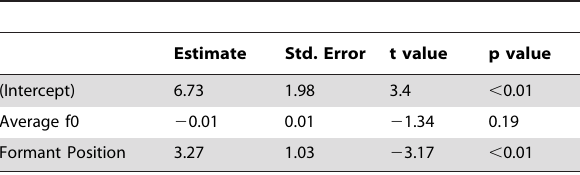
Table 9. Predictors for the regression model with female